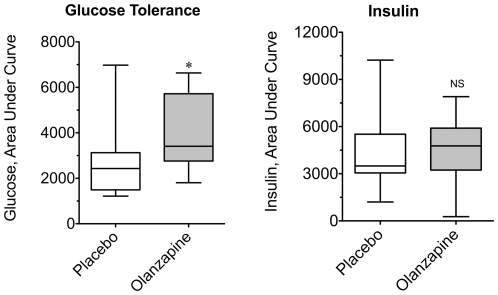
Effects of olanzapine on the glucose and insulin responses during oral glucose challenge.Blinded olanzapine or placebo tablets were self-administered by healthy volunteers for three days prior to conduction of a standard oral glucose tolerance test. In the morning, approximately 10–12 h following the final dose of placebo or drug compound, baseline blood samples were collected and then volunteers self-administered an oral glucose-containing solution. Serial blood samples were drawn at 30 min intervals for two hours. Plasma glucose and insulin concentrations were determined for each time point of the tolerance test. Area under the curve for (A) Glucose and (B) Insulin were calculated for each individual oral glucose tolerance test under placebo and active drug conditions. Data are expressed as box plots for the placebo and olanzapine-treated subjects. An asterisk indicates (P = 0.011) a significant difference between the medians of the placebo and olanzapine groups using a Wilcoxon matched-pairs signed rank test (n = 14).